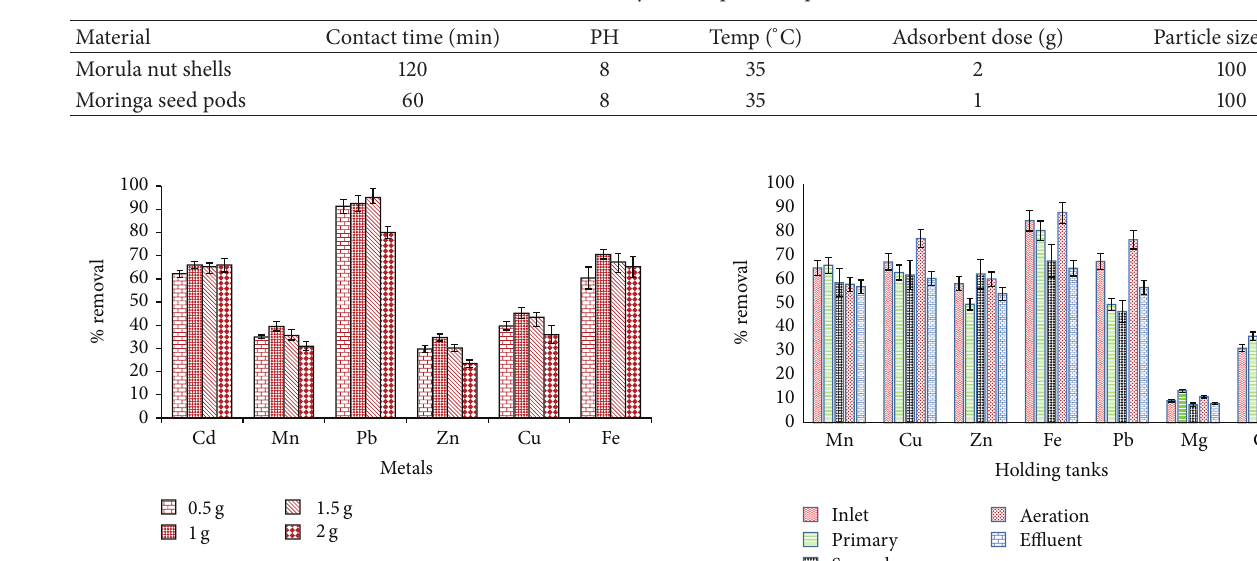
Table 3: Summary of the optimized parameters.